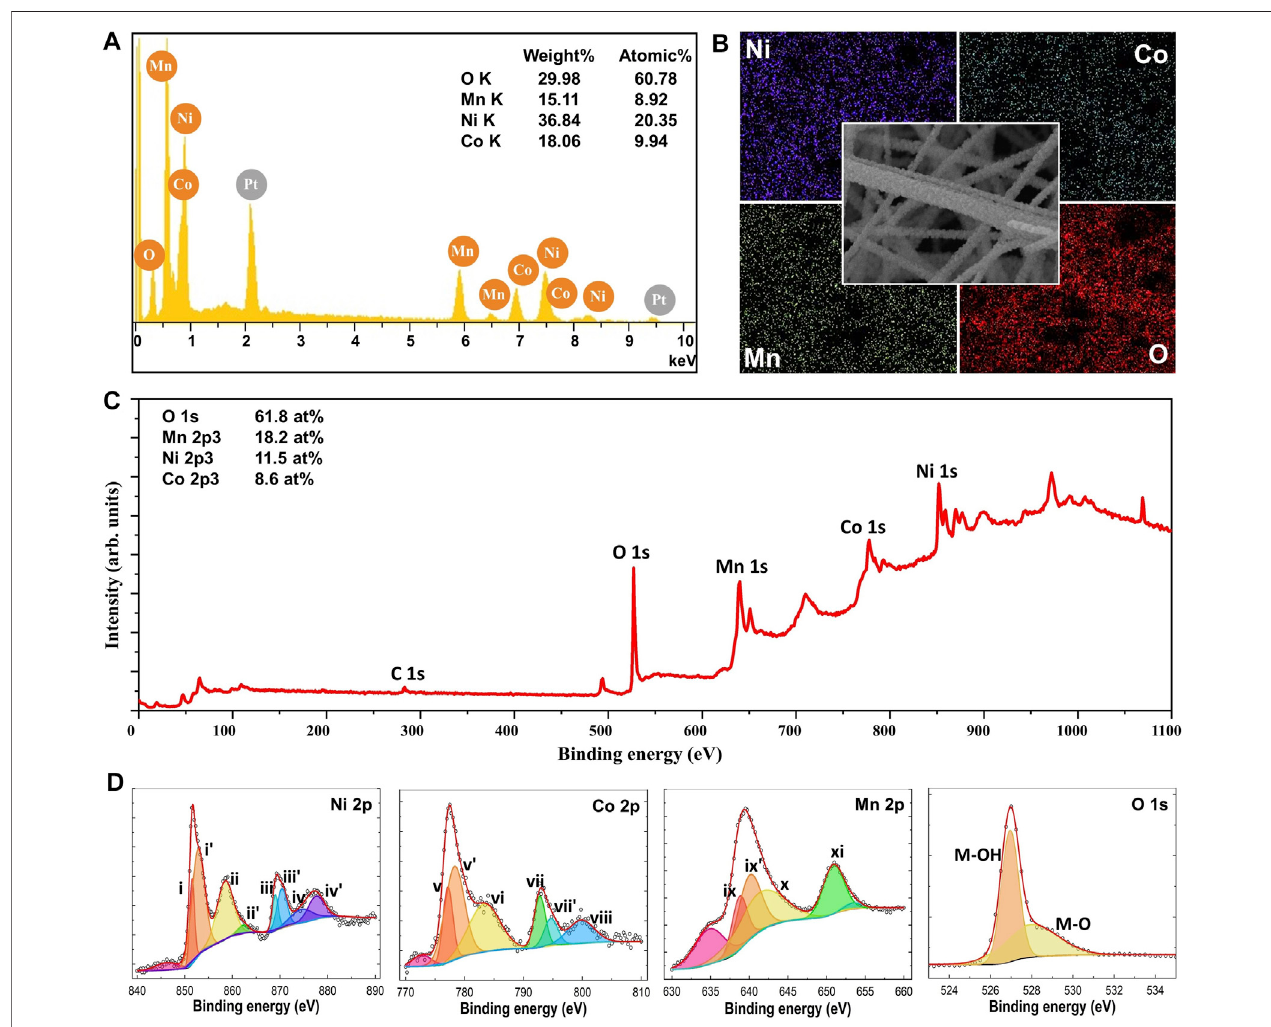
FIGURE 2 | (A) EDS spectra of nf-NCM showing that the sample is free from impurities. The Pt peak arises from the platinum coating sputtered onto the sample priortoFESEMimaging. (B) Elemental mappingofthesample,concludingthehomogenousdistributionofrespectiveelements. TheXPS (C) wide-scan spectraand (D) narrow-scan for respective